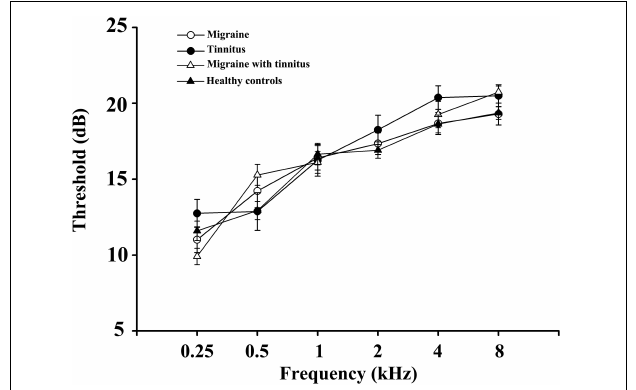
FIGURE 1 | Average hearing thresholds of migraine patients, tinnitus patients, migraine patient with tinnitus, and healthy controls. Data are presented as mean ±